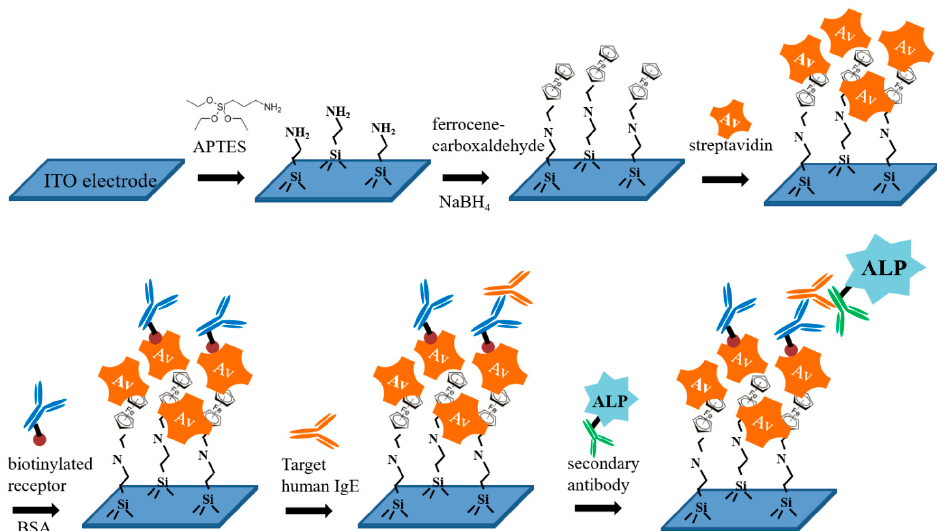
Scheme 1. Schematic illustration of the formation of SAMs and the immobilization of antibodies on the ITO electrode.